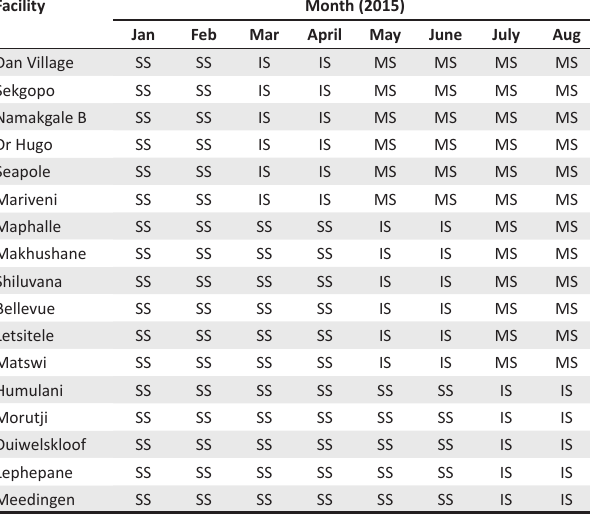
TABLE 1: Roving team technical support. Support process Planning